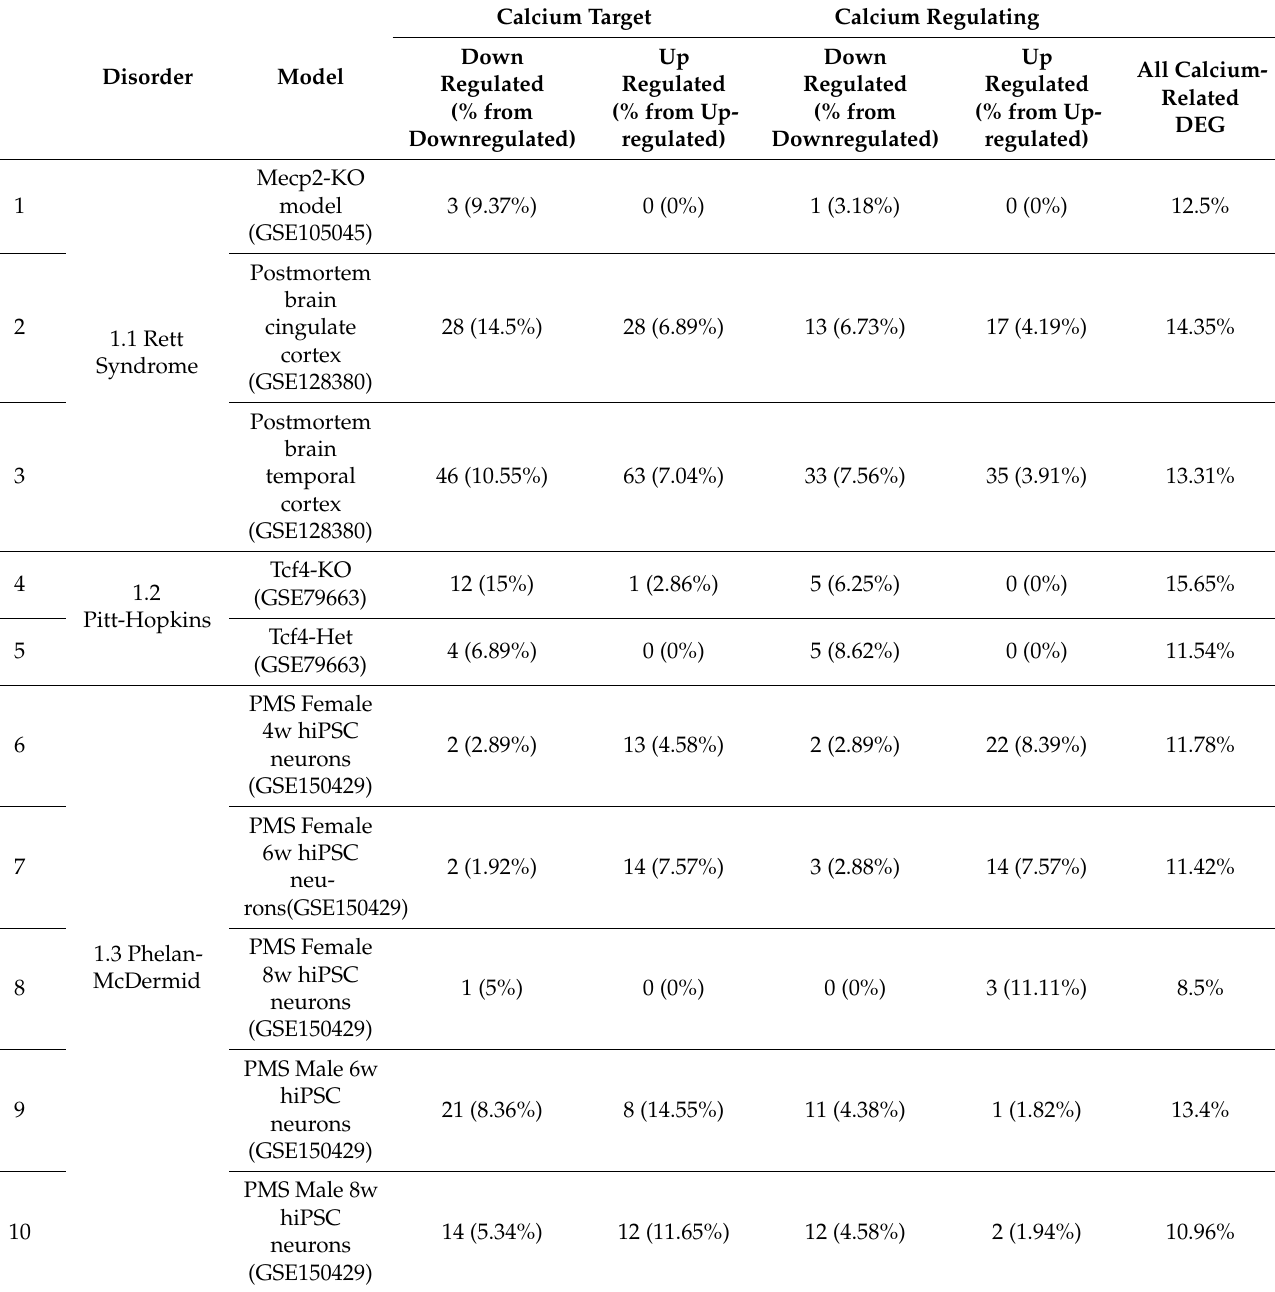
Table 2. Differentially expressed calcium-target and calcium-regulating